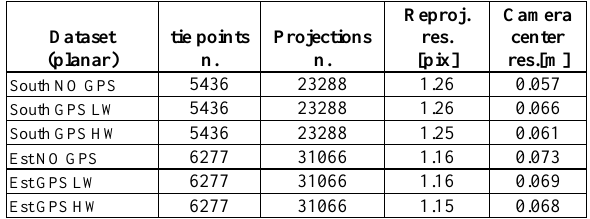
Table 14. Planar dataset: stats on collinearity residuals.